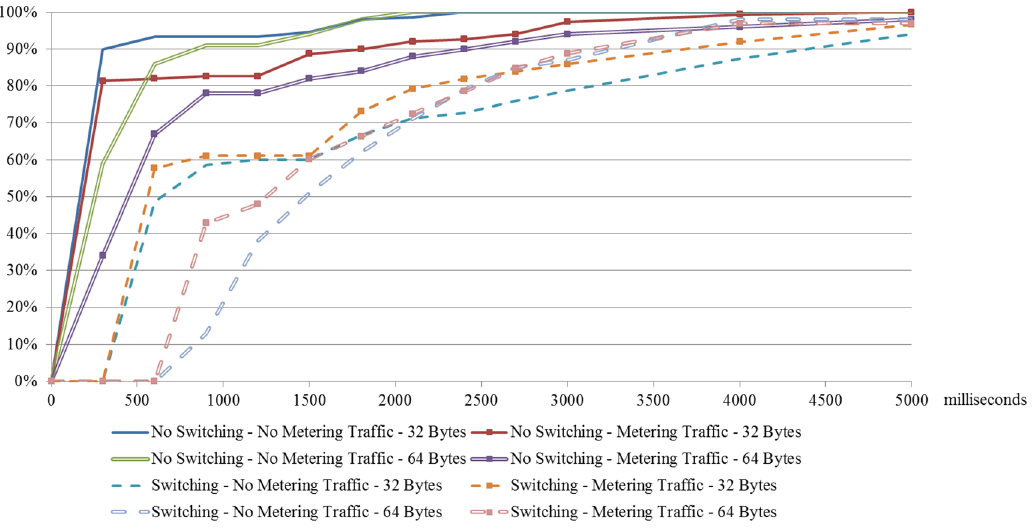
Figure 8. Internet control message protocol (ICMP) ping round ‐ trip delay histogram.